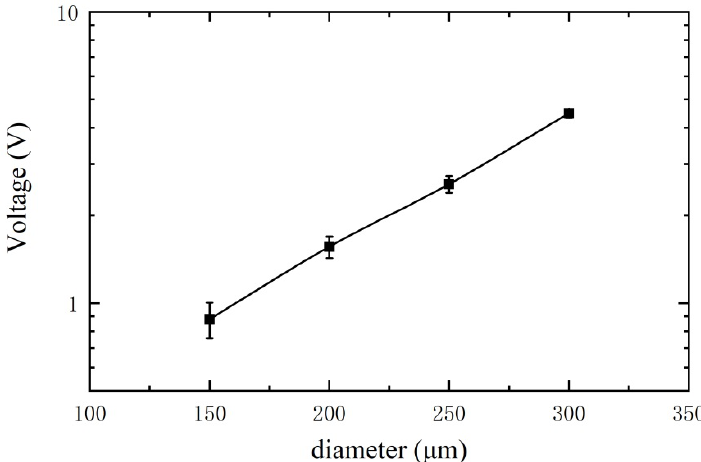
Figure 8. Variation of output voltage with metal debris size.